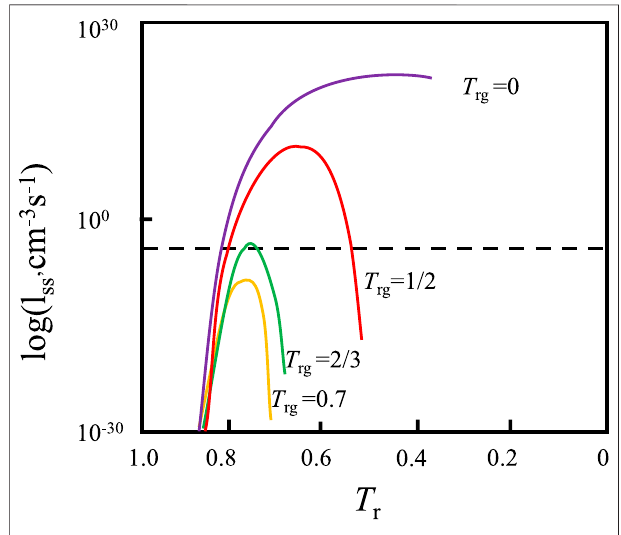
FIGURE 2 | Relationship between reduction temperature and the logarithm of the nucleation rate in Turnbull ’ s amorphous formation theory (Wang,